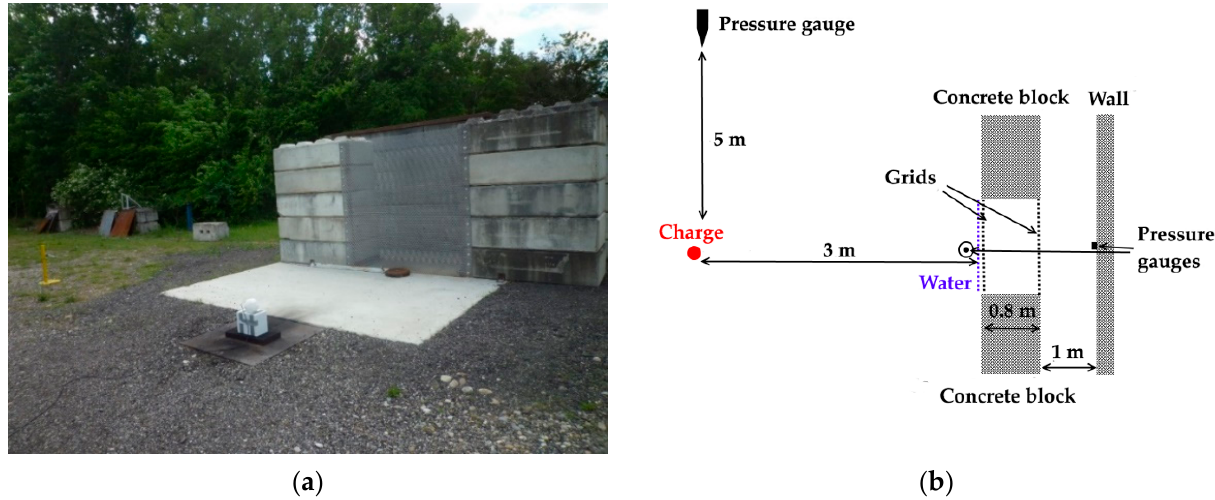
Figure 5. ( a ) Photography of the experimental setup; ( b ) Schematic diagram showing the charge, grids, concrete blocks, gauge in front of the grid and one side-on pressure gauge, placed at a right angle.